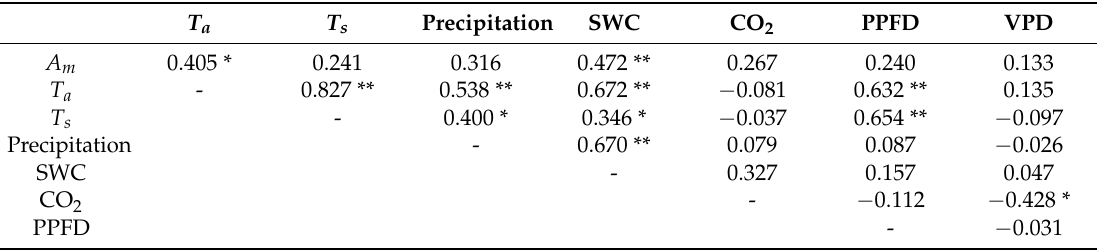
Table 2. The correlation coefficients between monthly CO 2 assimilation ( A m ) and environmental factors ( T a : air temperature, T s : soil temperature, SWC: soil water content, CO 2 : ambient CO 2 concentration, PPFD: photosynthetic photon flux density, VPD: vapor pressure deficit) of Fraxinus griffithii ( n = 35). T a